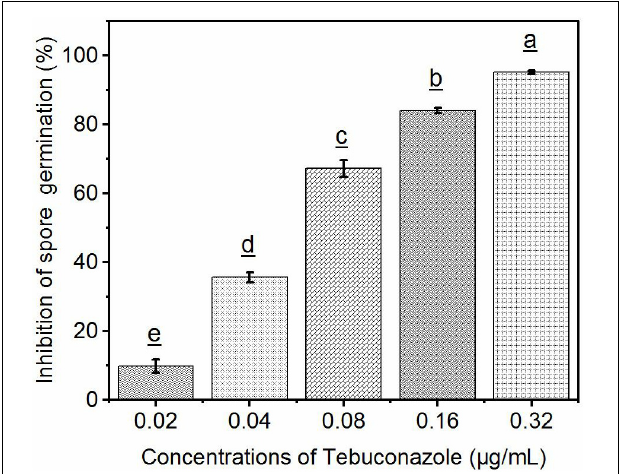
FIGURE 7 | Efficacy of tebuconazole against S. reilianum determined by inhibition of spore germination. Spore suspension was evenly distributed on the surface of YEPS plate containing different concentrations of fungicides, after 48 h of culture at 28 ◦ C, the rate of spore germination was determined by counting 100 spores in three different fields of view (300 spores per plate). A spore was considered germinated when the length of the germ-tube was longer than one half of the spore diameter. Each bar represents the mean ± se ( n = 3). Different lowercase letters indicate a significant difference between the different concentration of tebuconazole ( p <